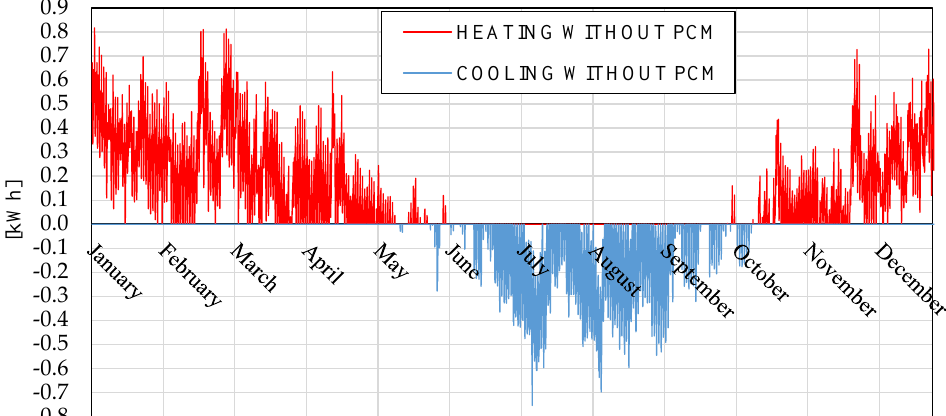
Figure 12. Hourly thermal requirements for heating (red) and cooling (blue) for CASE 1.